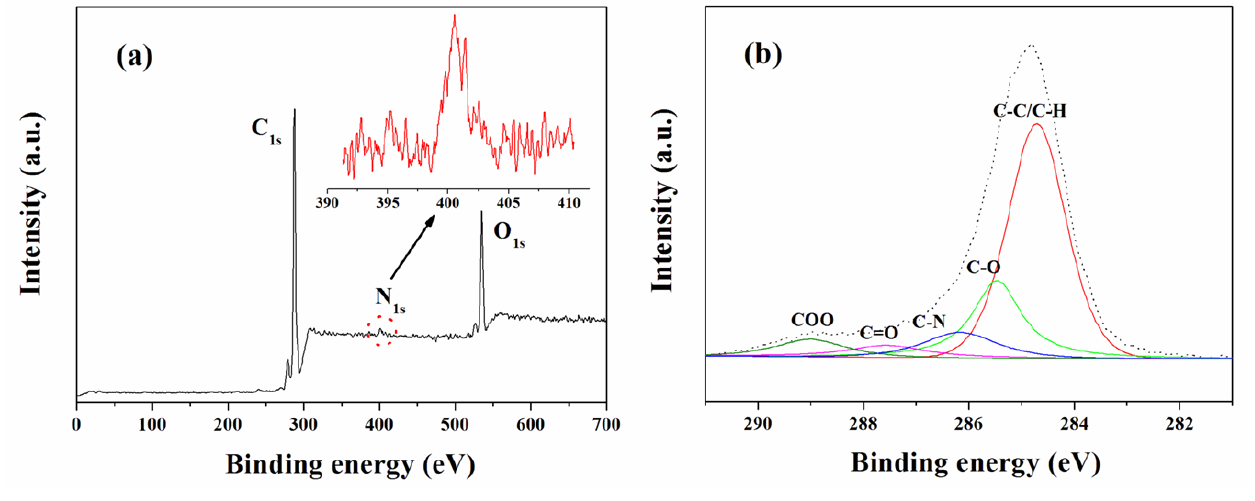
core level for the modified 1s core level spectra of the modified PE 1S